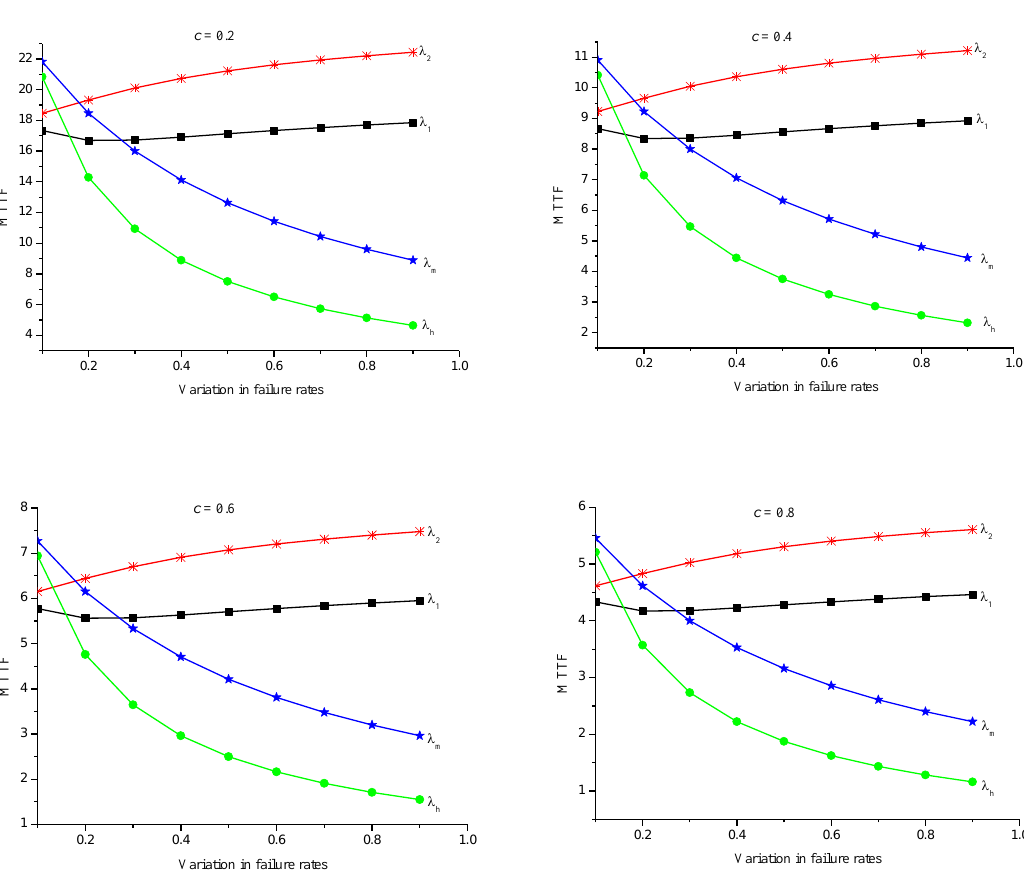
Figure 13. MTTF of the system with copula